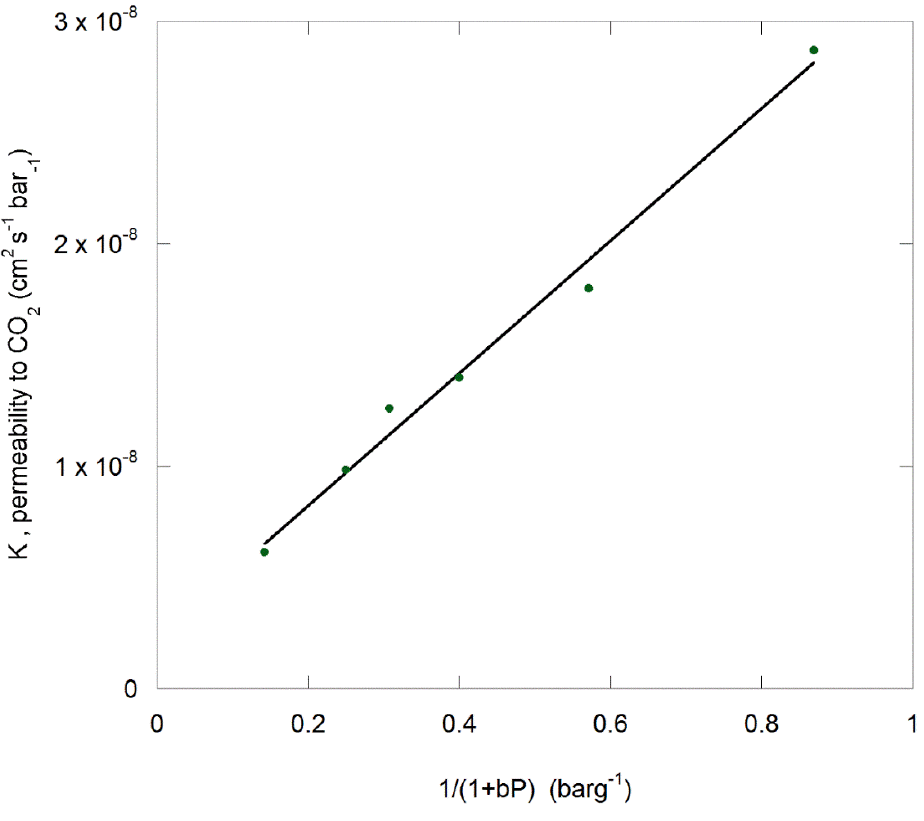
Figure 11. Permeability data supplied in Figure 8 for CO 2 permeating through PPS plotted as a function of inverse pressure with a b value of 0.015 bar − 1 .